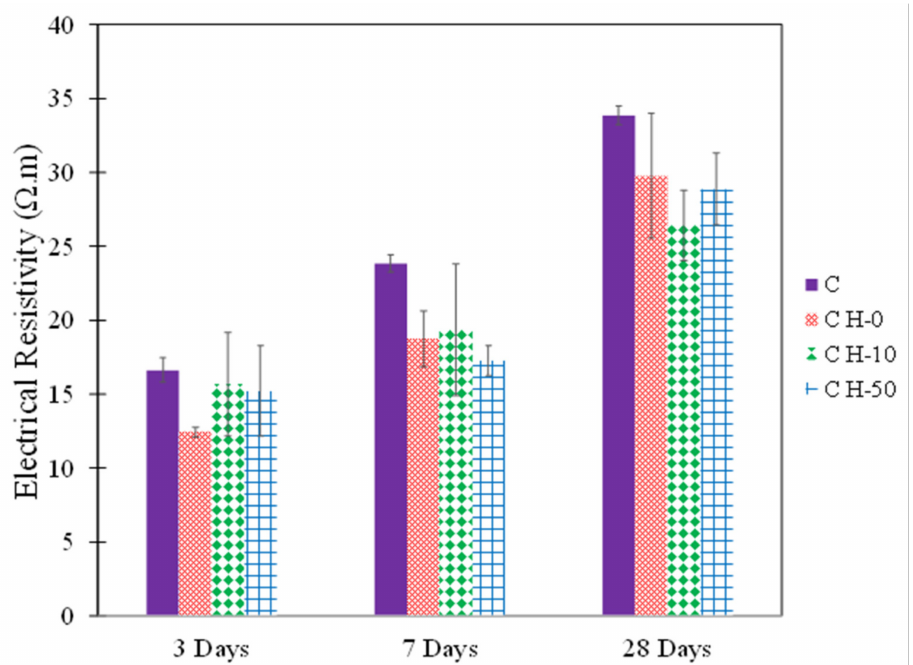
Figure 5. Electrical resistivity of the control cement paste and the pastes containing hydrogels at different